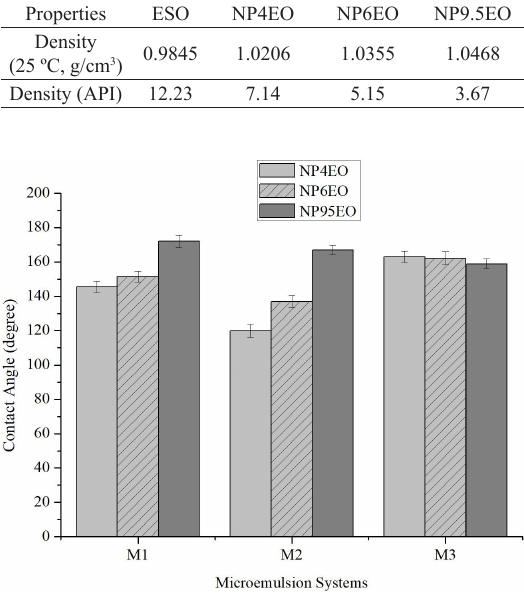
Figure 2. Contact angle behavior for the microemulsion